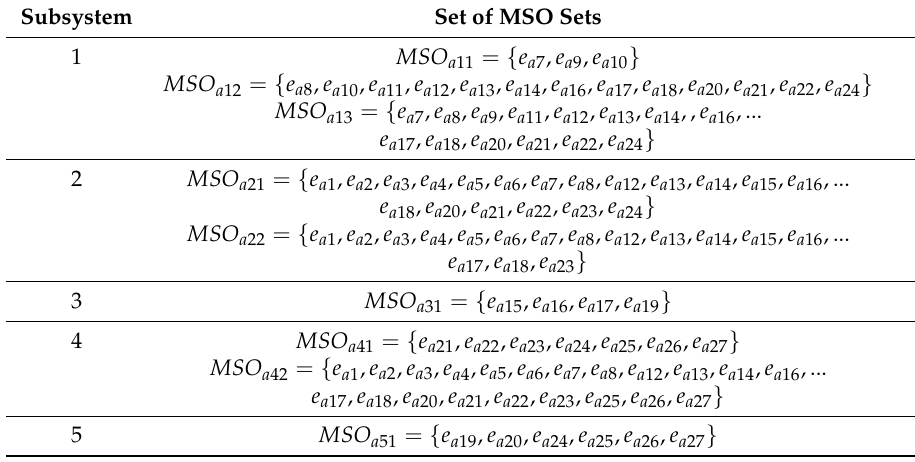
Table 4. Set of Minimal Structurally-Over-determined (MSO) sets for each local diagnoser using the MSO-based